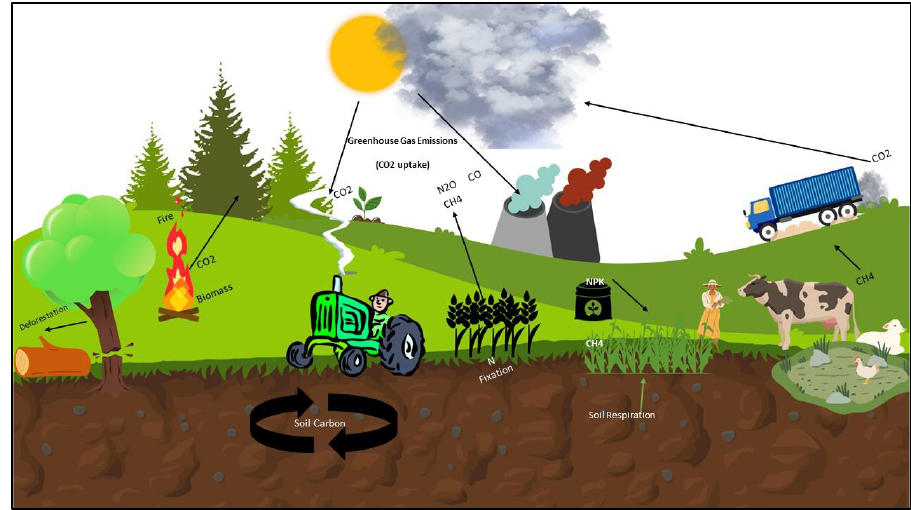
Figure 1. Greenhouse gas emissions in the agriculture sector (Picture credit: Saddam Hussain and Muhammad Habib Ullah).